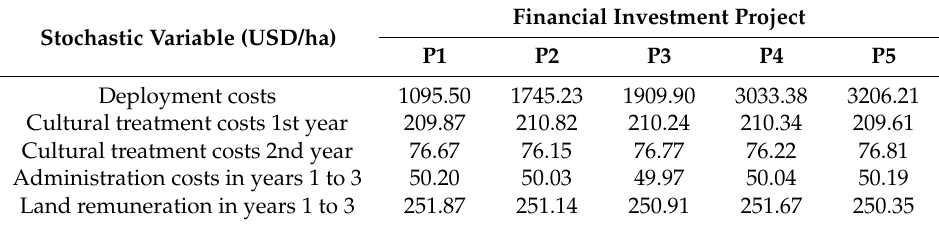
Table 2. Modal values of the cost of cultivation (USD/ha) for the implementation of investment projects in forest stands for biomass production of the main bole of eucalyptus.